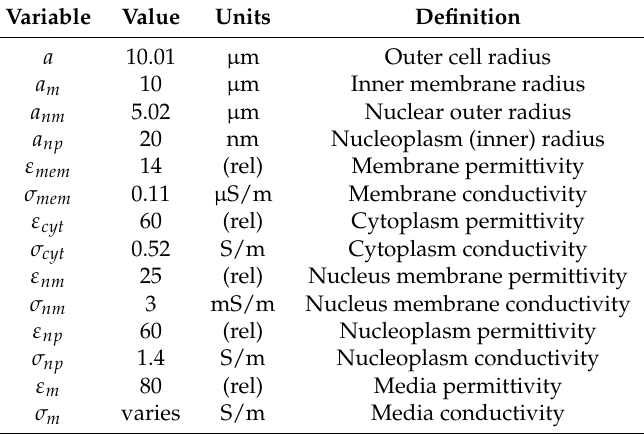
Table 1. Model parameters for DEP force sensitivity evaluation. These baseline values were used as a starting point and increased by 10% for permittivities and 100% for conductivities. Variation of cell radius increased the overall cell size, but did not change the thickness of any